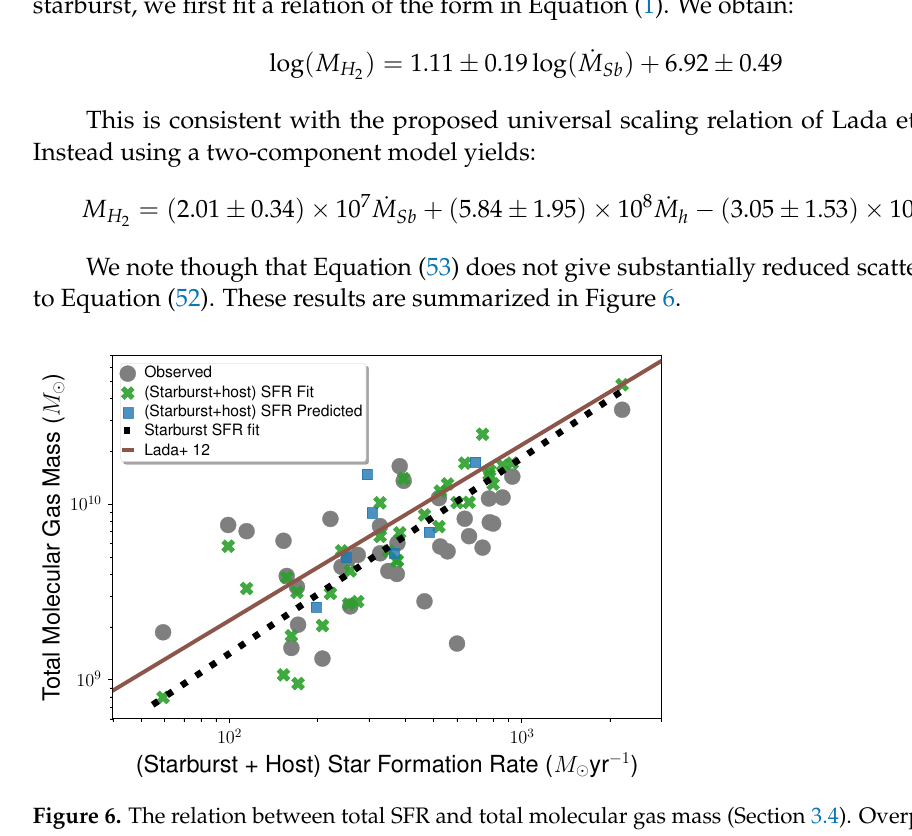
fit (Equation (53)), and 2